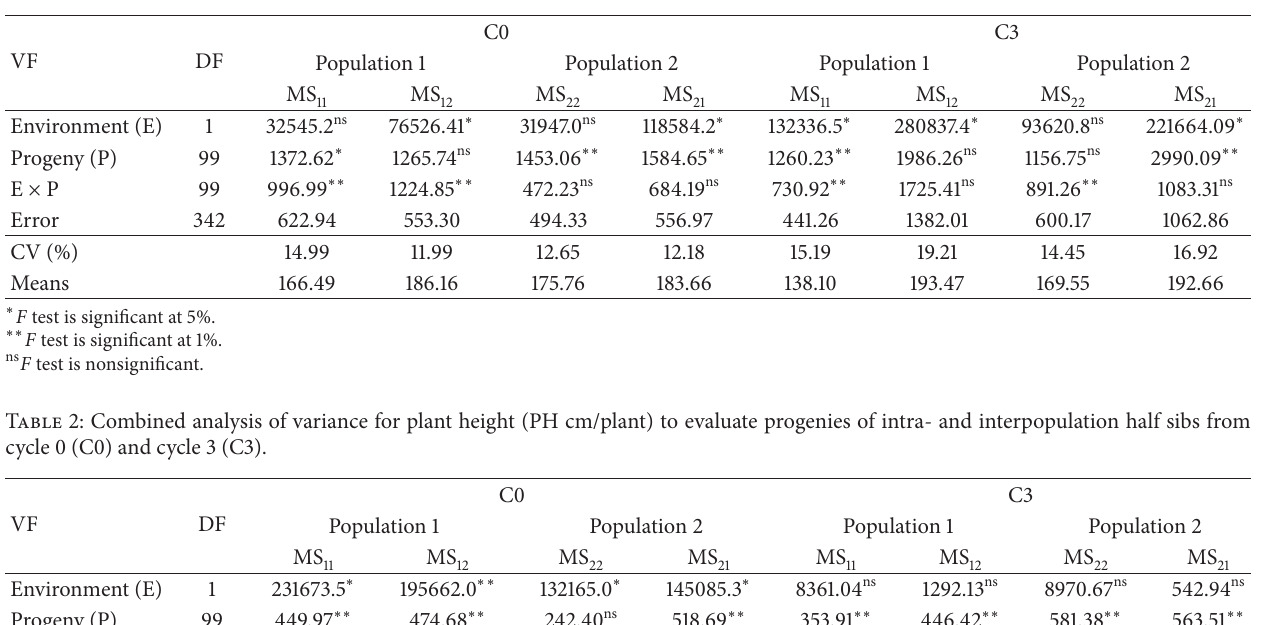
Table 1: Combined analysis of variance for unhusked ear weight (EW—g/plant) to evaluate progenies of intra- and interpopulation half sibs from cycle 0 (C0) and cycle 3 (C3).